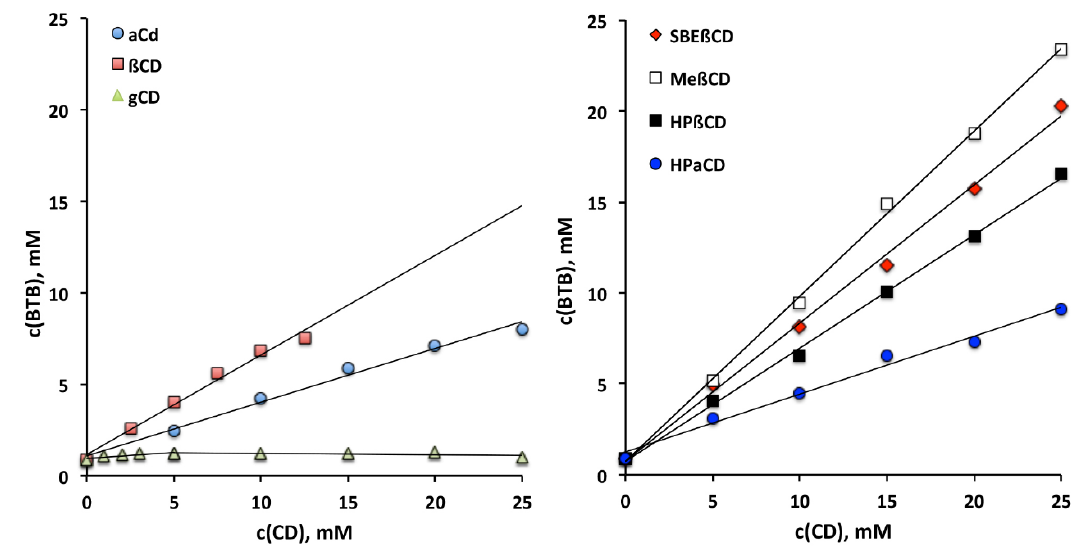
Figure 1. Phase-solubility diagrams of butamben (BTB) in the presence of natural (left) or derivative (right) CDs in water at 25 ± 0.5 °C. Table 1. Stability constants (K 1:1 ) and solubilizing efficiency of the different examined CDs towards butamben. Type of CD K 1:1 , M − 1